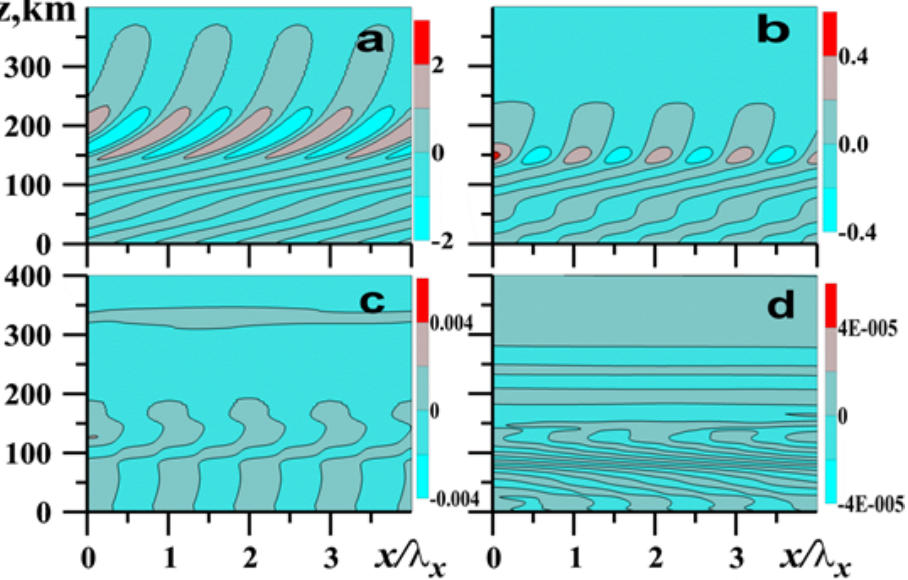
Figure 2. Simulated vertical velocity w for plane waves with period τ = 15 min, horizontal wavelength λ x = 90 km at time t = 40 τ ( a ); τ = 7.5 min, λ x = 45 km, t = 40 τ ( b ); τ = 5 min, λ x = 30 km, t = 50 τ ( c ); τ = 0.5 min, λ x = 6 km, t = 90 τ ( d ) for the background temperature profile shown in Figure 1. Figure 2b,c represent intermediate wave periods. In Figure 2b for τ = 7.5 min,